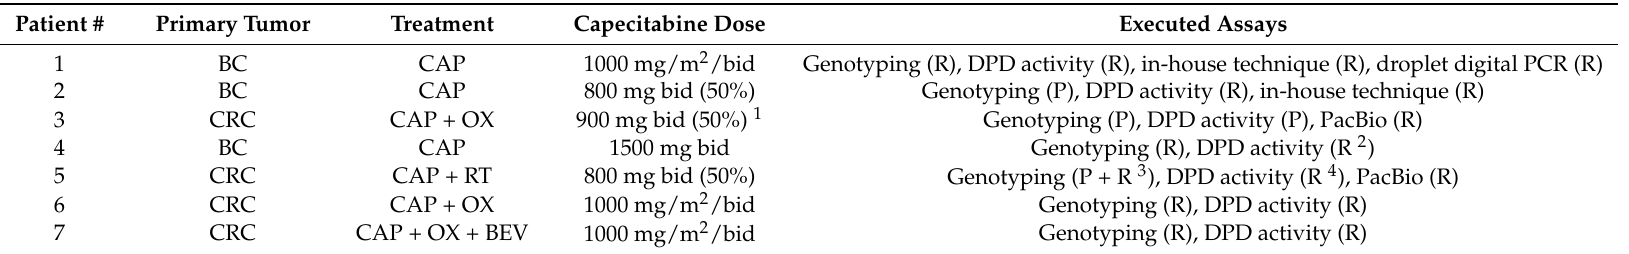
Table 1. Characteristics of patient cases. Shown per patient are primary tumor, treatment, capecitabine dose, executed assays (genotype, dihydropyrimidine dehydrogenase (DPD) enzyme activity, and additional assays) information. Additional assays are droplet digital PCR, PacBio sequencing (Menlo Park, CA, USA), or an in-house developed technique. For the executed assays, it is shown whether these were executed prior to treatment (P) or retrospectively (R). Abbreviations: BC: breast cancer; CRC: colorectal cancer; CAP: capecitabine; RT: radiotherapy; OX: oxaliplatin; BEV: bevacizumab; bid: bis in die /twice a day.